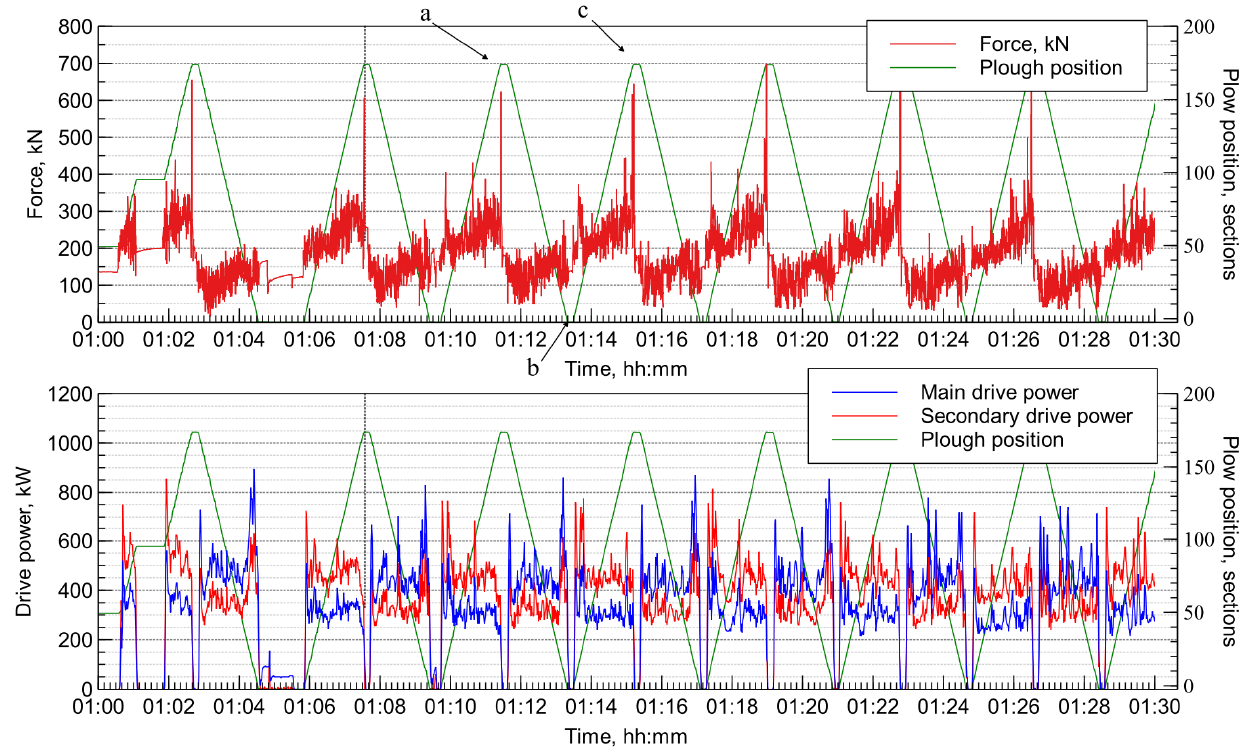
Figure 13. Recorded force measurements and plough system data: main drive side. a—peak in the measured force, b and c—points of changes in the plough travel direction.